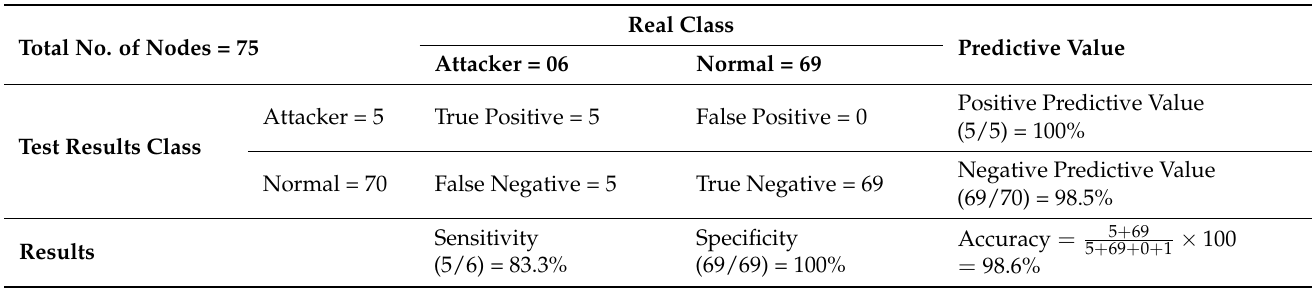
Table 8. Example of an accuracy rate